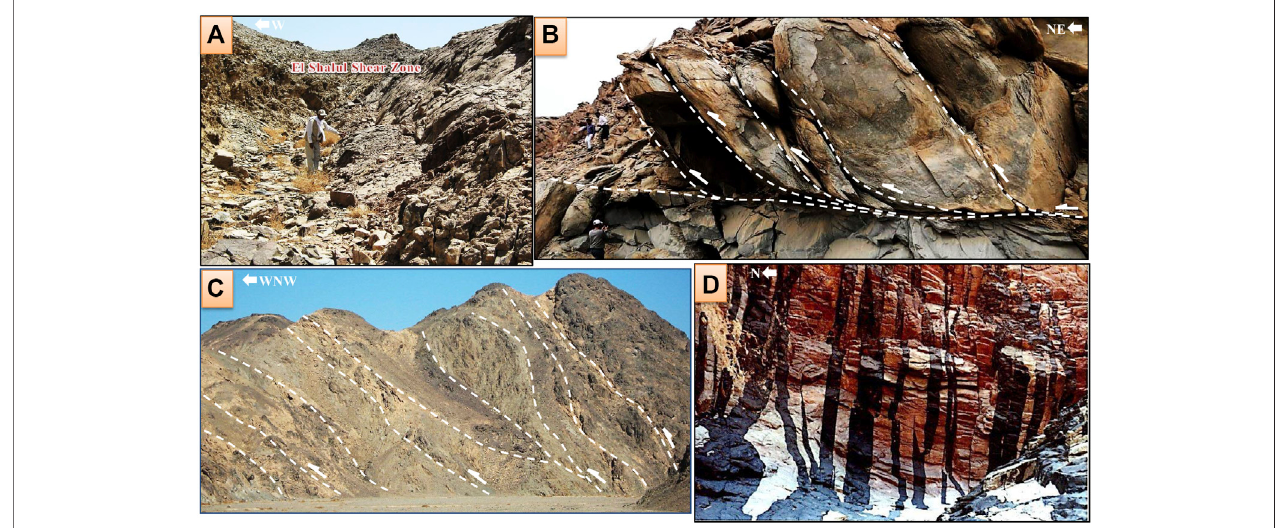
FIGURE11| Fieldphotographsindicatingatransitionfromcompressiontoextensionalshearing alongElShalulShear Zone (A) , transpressive structurestotheSE of Meatiq dome and along the Atalla Shear Zone (B,C) , respectively, and remarkable dyke swarms in the extensional province at Wadi El Thelma south Gabal Gattar granitic pluton (D)